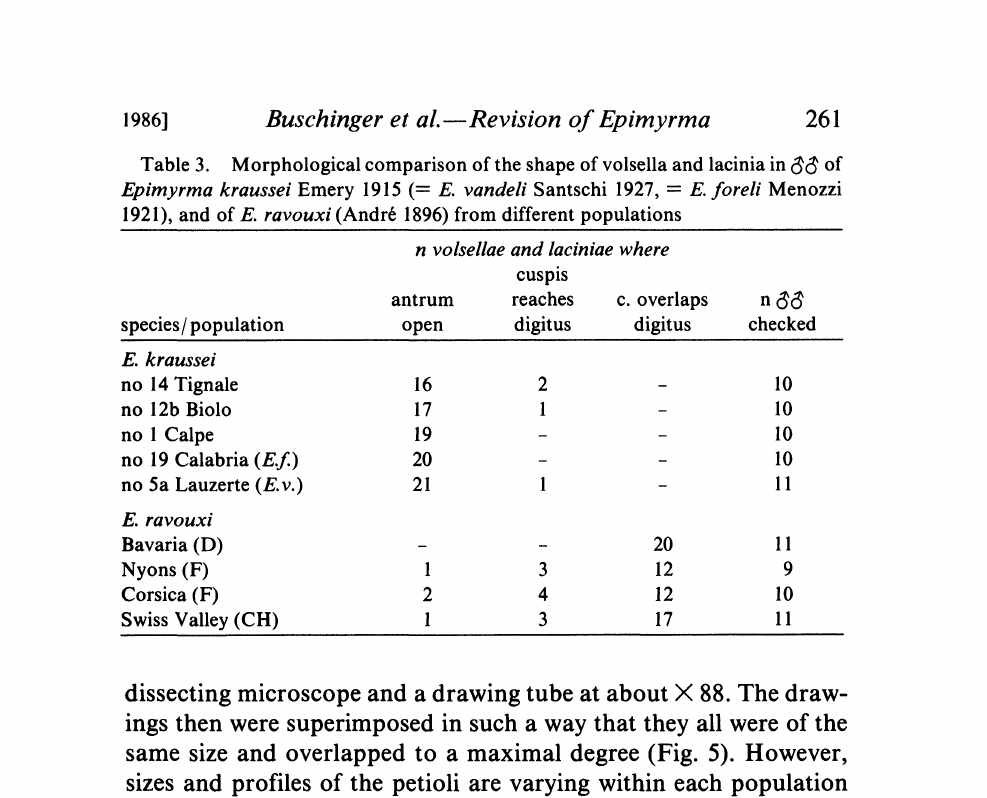
261 Table 3. Morphological comparison of the shape of volsella and lacinia in of Epimyrma kraussei Emery 1915 (= E. vandeli Santschi 1927, E. foreli Menozzi 1921), and of E. ravouxi (Andr6 1896) from different populations n volsellae and laciniae where cuspis antrum reaches c. overlaps n species/population open digitus digitus